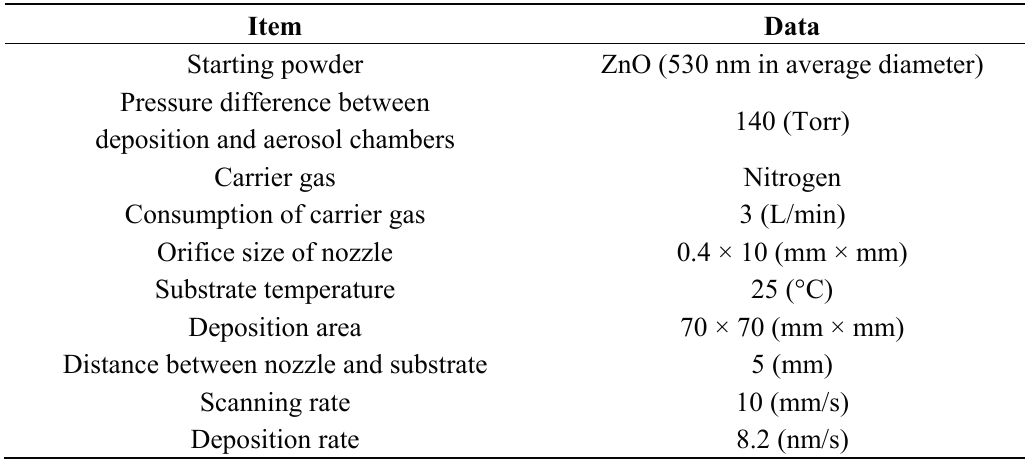
Table 1. Deposition parameters for AD.